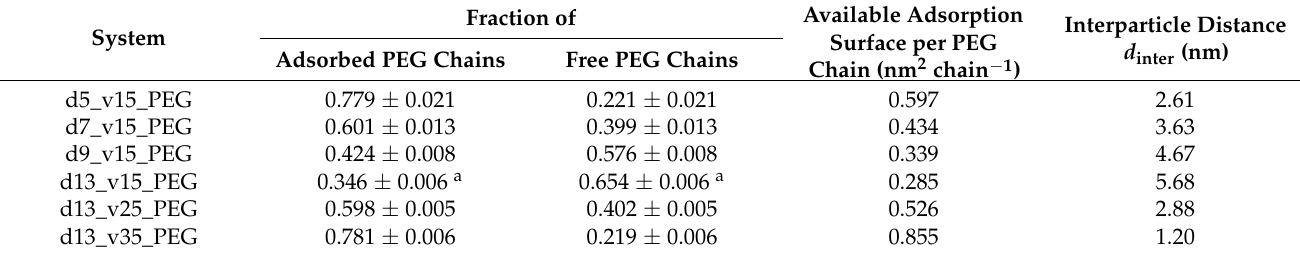
Table 3. MD predictions for the fraction of adsorbed and free chains in the simulated nanocomposites (systems 2–7) at T = 413 K and p = 1 atm. In the third column of the table, we report the available adsorption surface area per PEG chain. The fourth column denotes the inter-particle distance d inter in each nanocomposite examined. a Data obtained from ref. [21]. Fraction of System